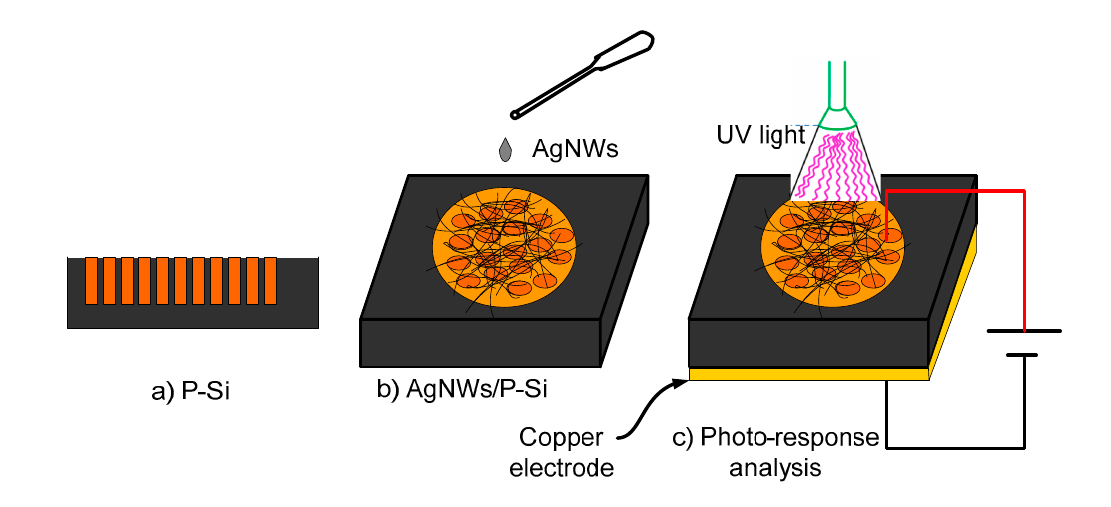
Figure 10. Schematic diagram of (a) the fabricated P-Si photodetector, (b) the AgNWs/P-Si photodetector, and (c) the photo-response analysis .